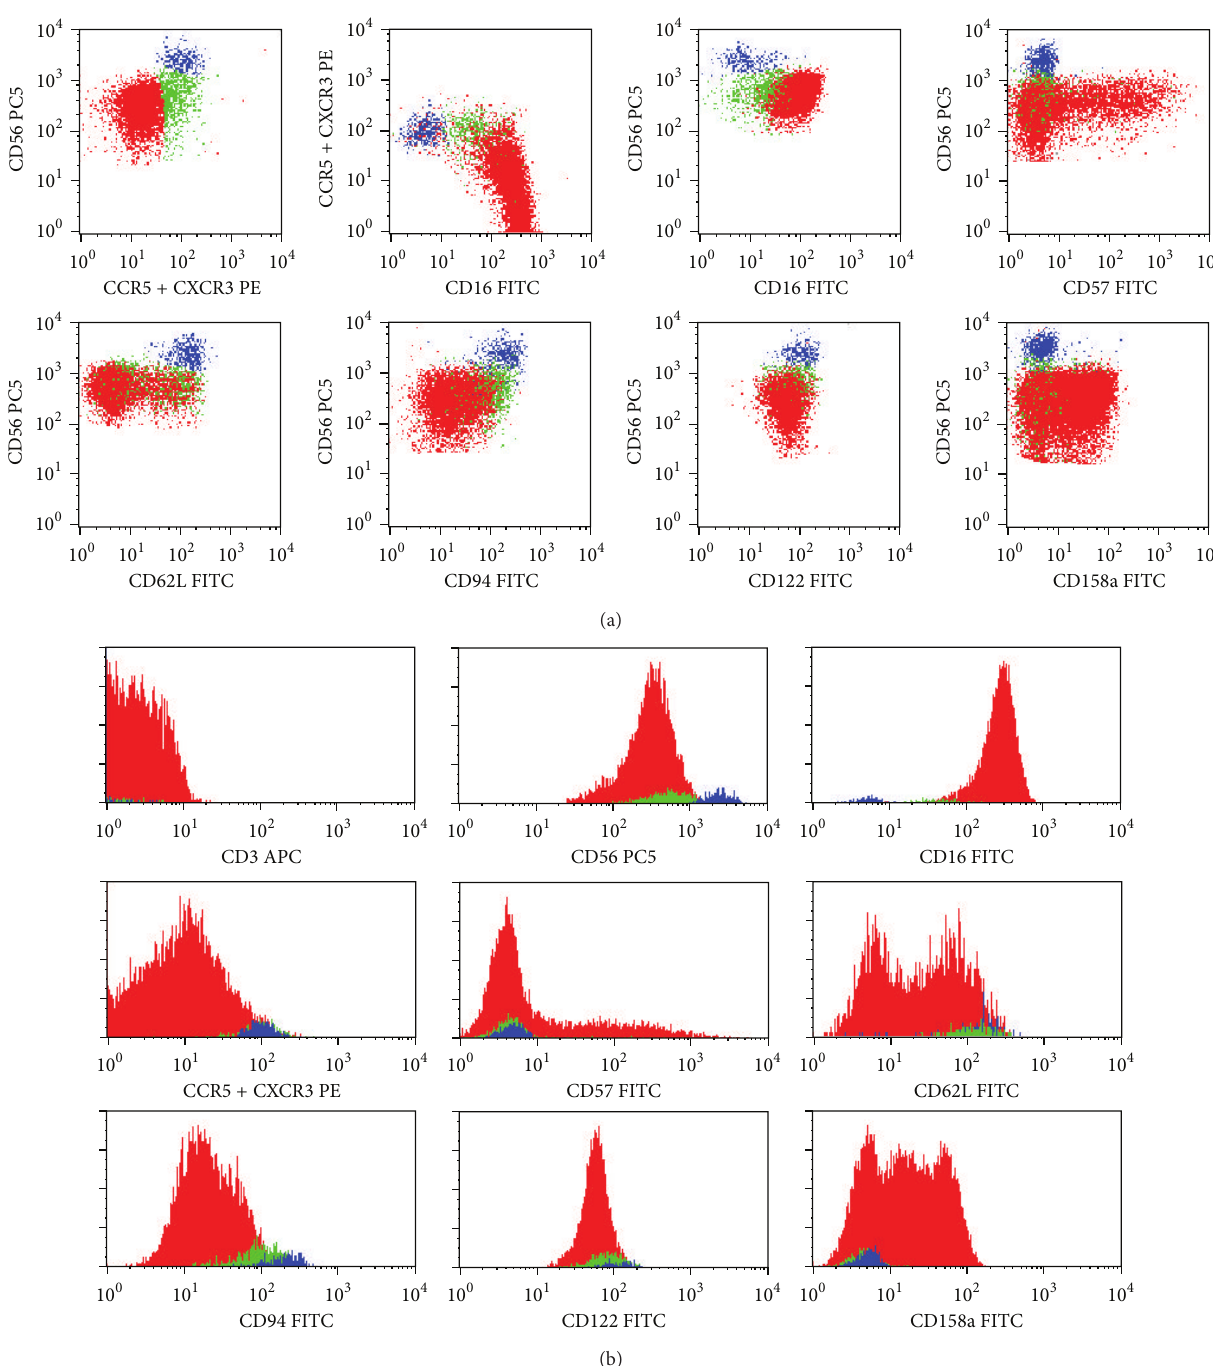
Figure 2: Representative dot plots (a) and histograms (b) illustrating the expression of the CD3, CD16, CD56, CD57, CD62L, CD94, CD122, and CD158a molecules on CD 56 + low CXCR3/CCR5 − (red dots), CD 56 + int CXCR3/CCR5 + (green dots), and CD 56 + high CXCR3/CCR5 + (blue dots) NK-cells in normal peripheral blood (PB). In order to obtain the dot plots showed in this figure, PB cells were stained with APC-conjugated anti-CD3, PC5-conjugated anti-CD56, PE-conjugated anti-CXCR3 + PE-conjugated anti-CCR5, and FITC-conjugated monoclonal antibodies against CD16, CD57, CD62L, CD94, CD122, or CD158a molecules. Total CD56 + cells were gated using the strategy illustrated in Figure 1. Then, using the CD56/CCR5 + CXCR3 dot plot (first dot plot), three different CD56 + NK-cell populations were identified based on thelevels of expression of CD56 and CXCR3/CCR5:CD 56 + low CCR5/CXCR3 − (red dots),CD 56 + int CCR5/CXCR3 + (green dots), and CD 56 + high CCR5/CXCR3 + (blue dots). As it can be seen in the remaining dot plots and histograms, these NK-cell populations differ on the expression of several cell surface molecules. The percentage of cells staining positively for each molecule analyzed, as well as the mean fluorescence intensity of antigen expression and its coefficient of variation, was calculated after gating separately for each NK-cell population and is shown in Table 1 (data is not shown in the figure, for